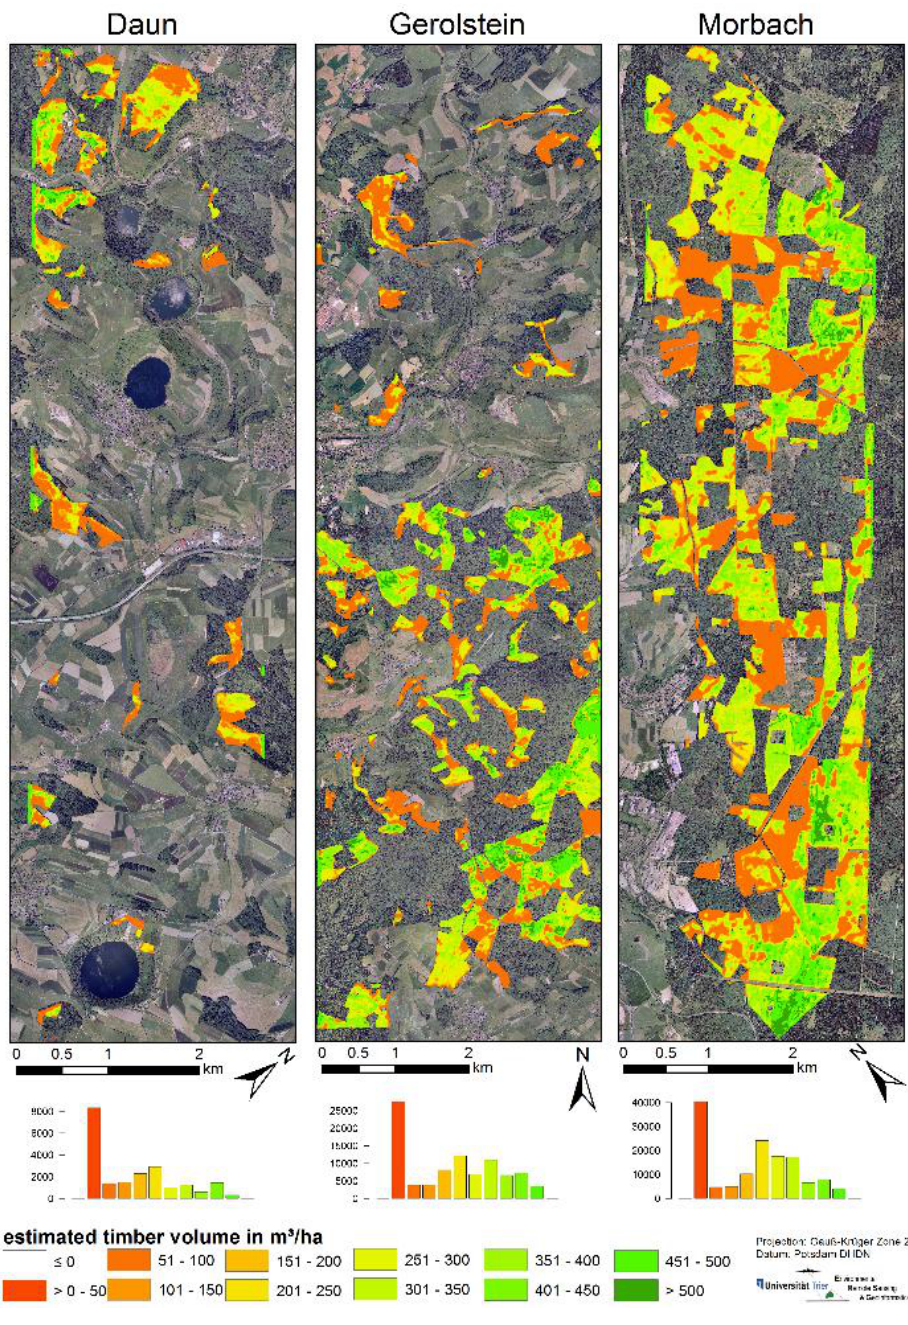
Figure A3. Timber volume prediction map based on k -NN with simulated Sentinel-2 data. Conflicts of